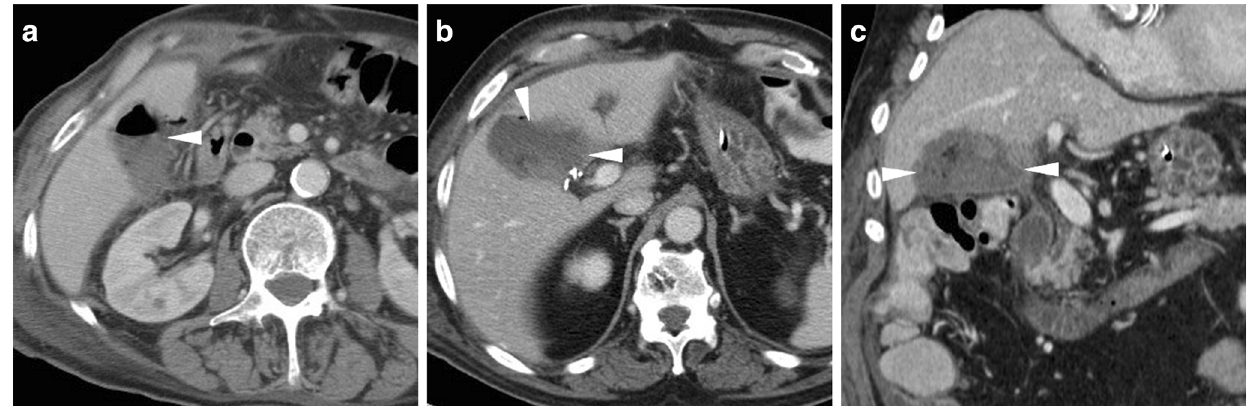
Fig. 4 Common appearance of non-infected postoperative collections in the gallbladder fossa. a Forty-eight hours after laparo-endoscopic rendez- vous cholecystectomy, the surgical bed is occupied by a mixed collection ( arrowhead ) containing non-dependent air and dense fluid, lacking a